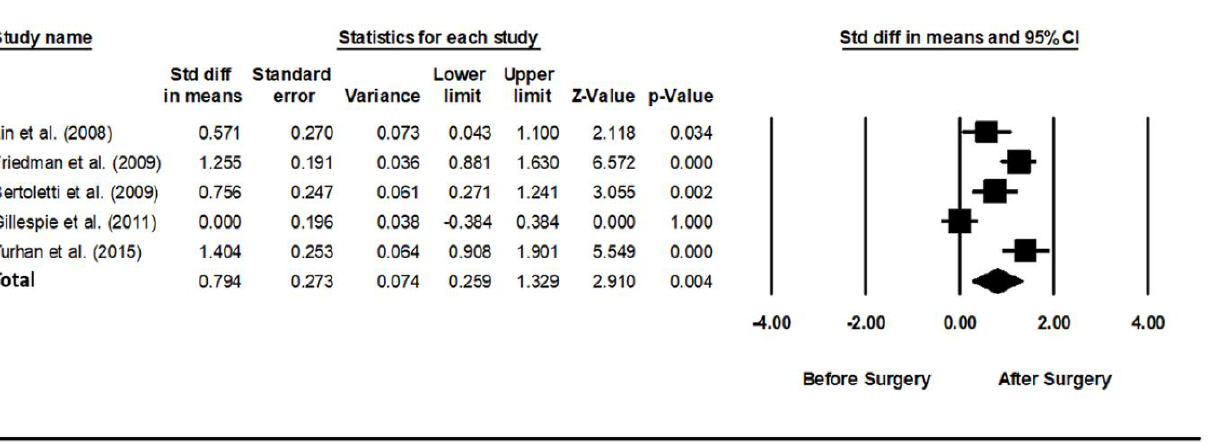
Figure 4. Forest plot for the effects of pharyngeal obstructive sleep apnea surgery on positive airway pressure usage time. The summed usage time of PAP increased significantly after pharyngeal OSA surgery compared to before surgery. Std diff, standardized difference; CI, confidence interval [28,30–33].